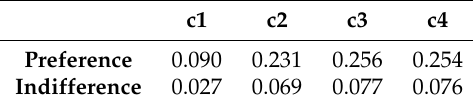
Table A5. Preference and indifference